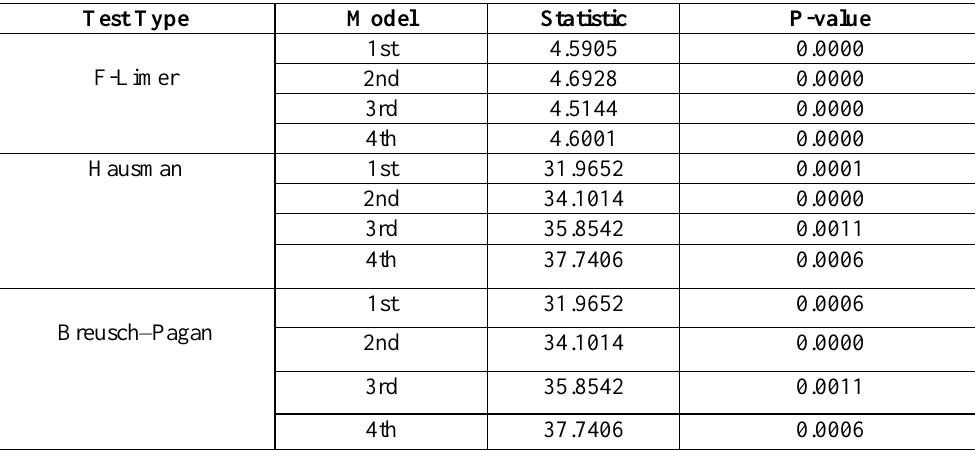
Table 3. Results of detecting the best